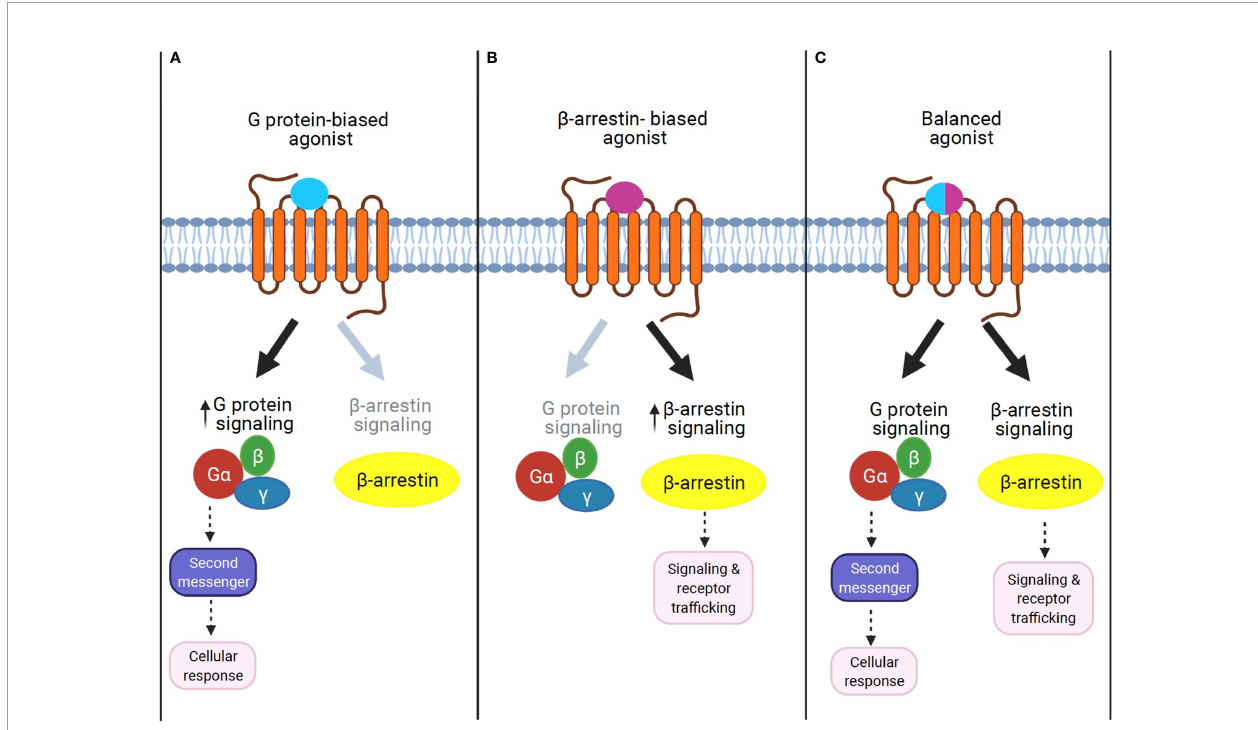
FIGURE 2 | The concept of GPCR signaling: biased signaling. (A) G protein-biased agonist. Biased agonists selectively activate the GPCR-dependent signaling pathway. Previous studies demonstrate that sustained G protein-mediated signaling can affect cellular response through second messenger activation. (B) b -Arrestin biased agonist. Biased agonists selectively activate the b -arrestin-dependent signaling pathway. The b -arrestin-mediated signaling leads to distinct physiological outcomes. (C) Balanced agonist. Balanced agonists activate both the G protein- and b -arrestin-dependent signaling